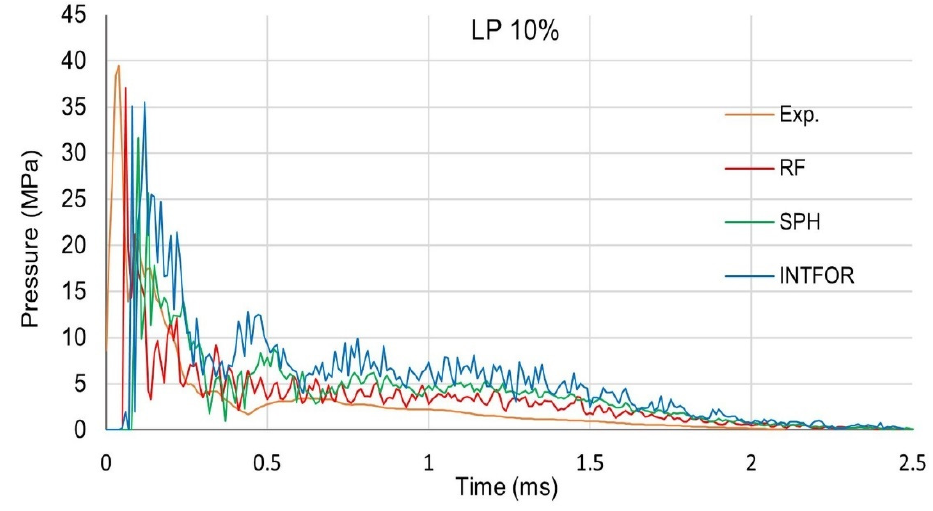
Figure 26. Pressure at center of impact for experimental test and numerical simulations (RF, SPH, INTFOR).